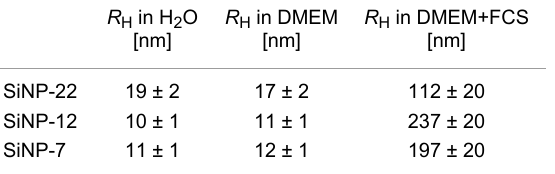
Table 2: Hydrodynamic radii of SiNPs in water, DMEM and DMEM +